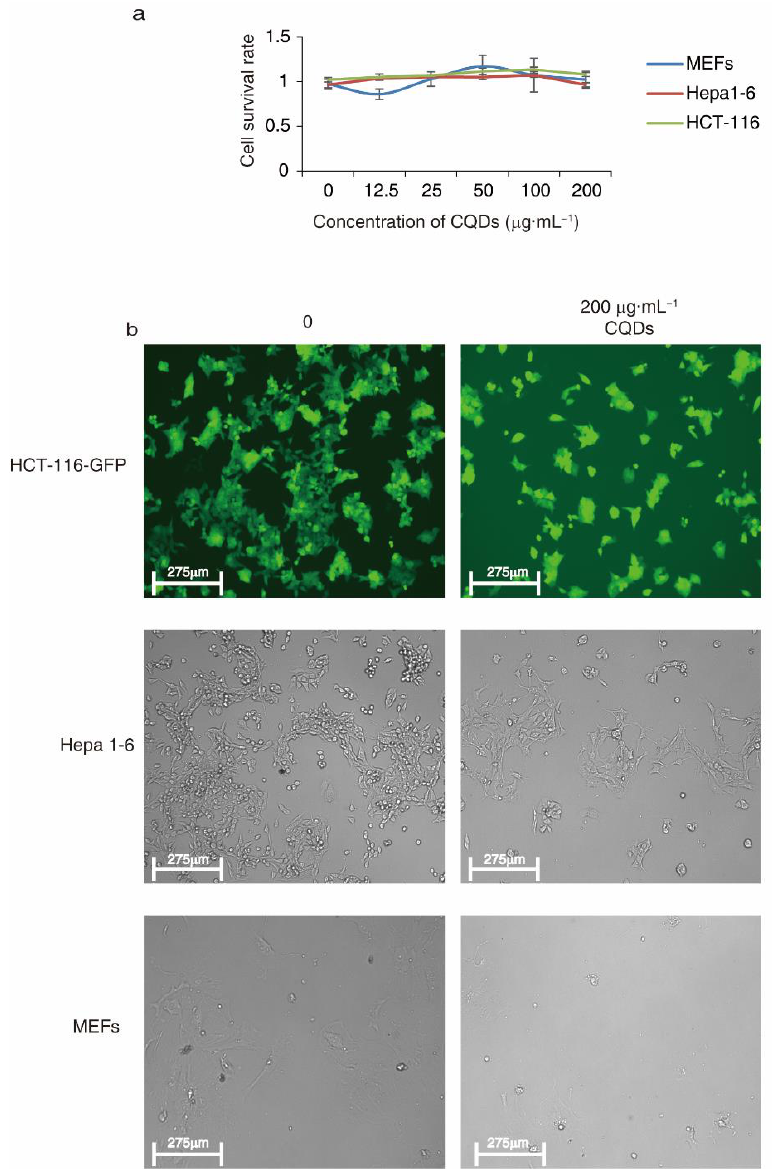
Figure 6. Cytotoxicity of CQDs prepared from chicken bones. ( a ) Cell survival rates measured in indicated cells by CCK-8 assay. The indicated concentrations of CQDs were used to treat cells for 48 h. ( b ) Cell morphology of HCT-116-GFP, Hepa 1-6 and MEFs after treatment with or without 200 μg·mL −1 CQDs for 48 h.